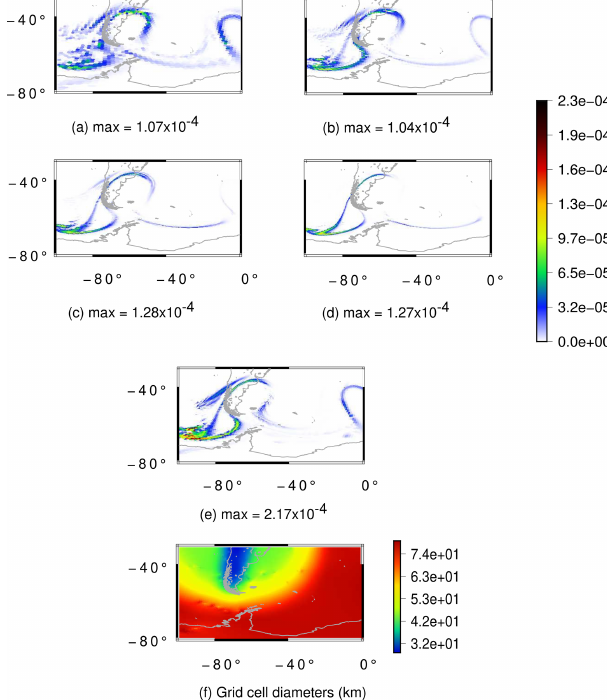
Figure 19. Flow over a mountain test case for the moist shallow- water model: cloud field at day 30 for the grids UR6 (a) , UR7 (b) , UR8 (c) , UR9 (d) and VR7 (e) as well as the cell diameters in kilo- meters for the VR7 grid (f) . The UR6, UR7, UR8 and UR9 grids have an average resolution of 120, 60, 30 and 15km, respectively.